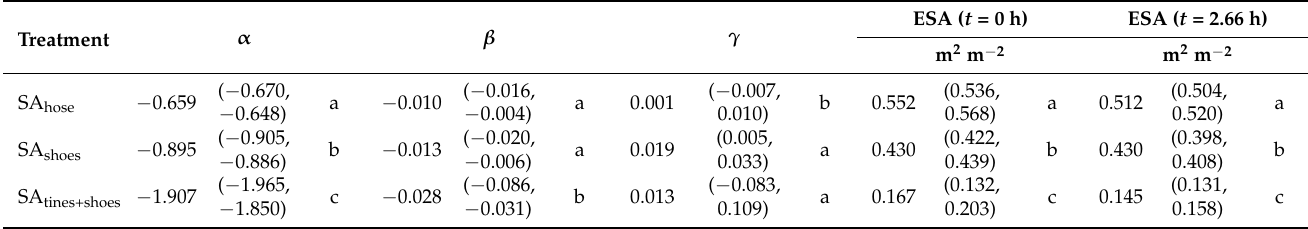
Table 8. Parameter estimates used in Equations (2) and (3) to analyze EXP ESA.B data. Average